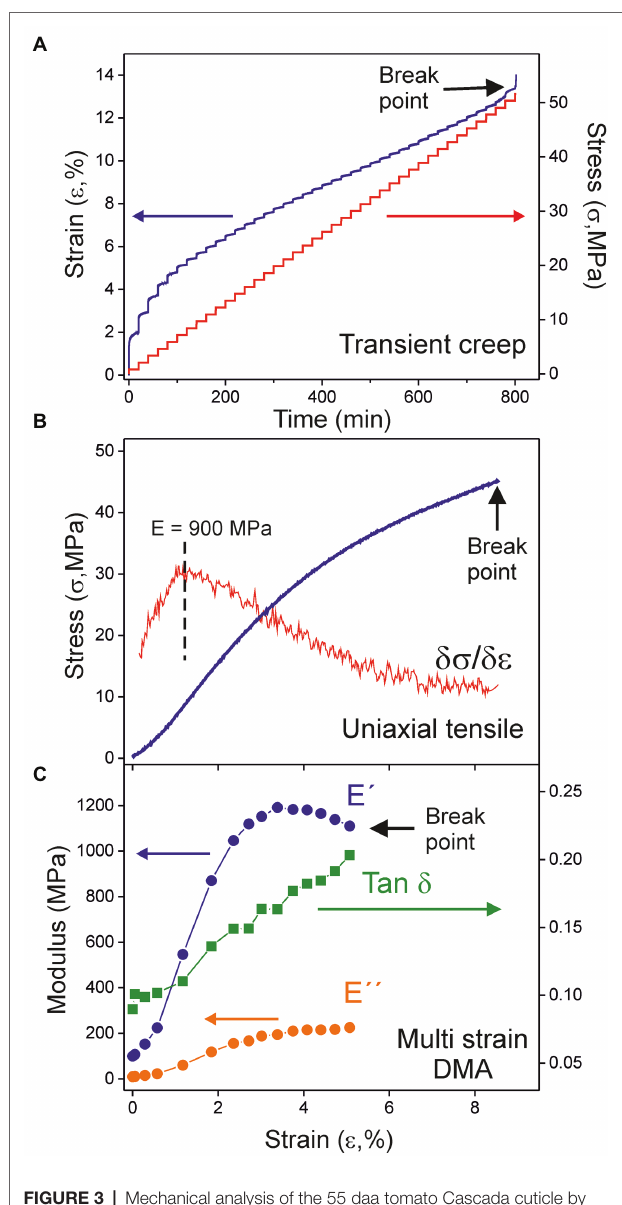
FIGURE 3 | Mechanical analysis of the 55 daa tomato Cascada cuticle by (A) transient creep, (B) uniaxial tensile, and (C) multi strain dynamic mechanical analysis